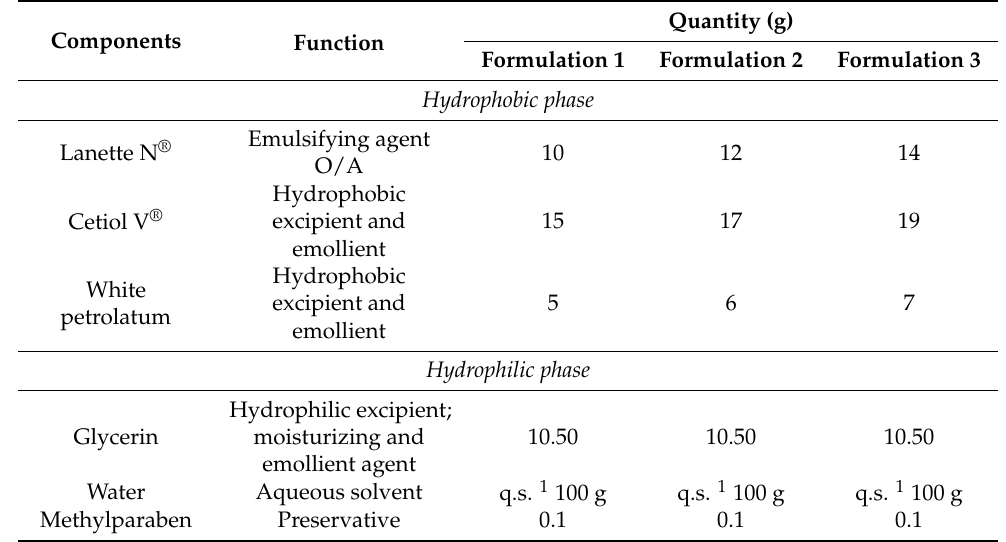
Table 1. Qualitative and quantitative composition of the 3 base